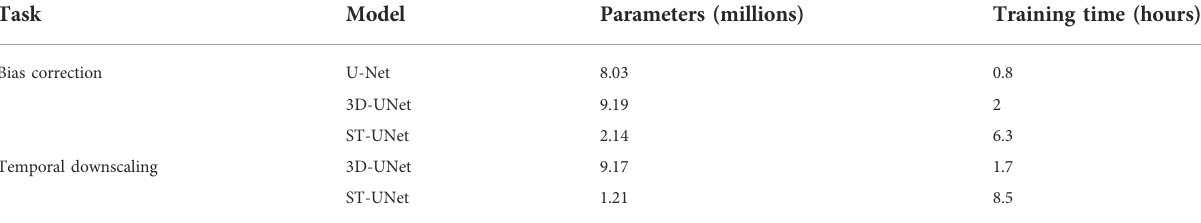
TABLE 1 The parameters and training time of different models in bias correction and temporal downscaling tasks.